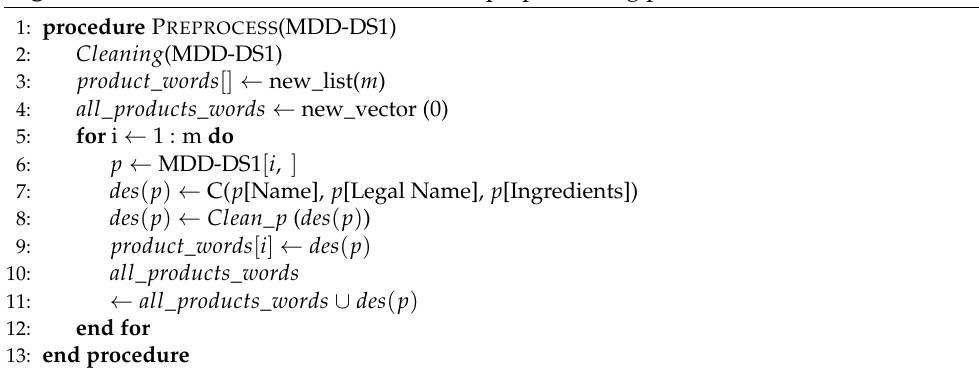
Algorithm 1 RS-CF: PRO-COM and PK-BD preprocessing pseudocode.